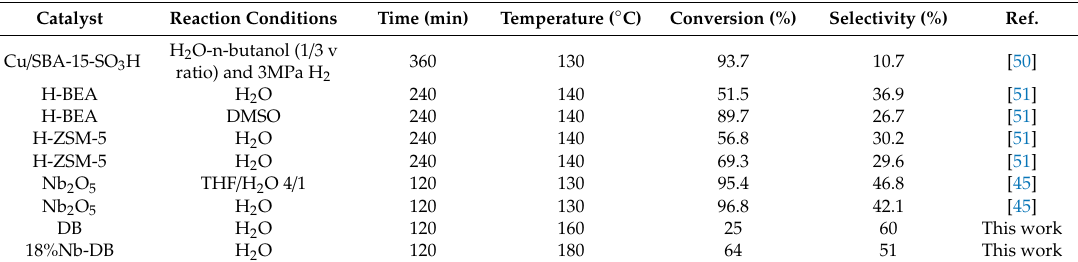
Table 8. Comparative conversion of xylose and selectivity for furfural using di ff erent catalysts and solvents, at specific temperatures and reaction conditions.